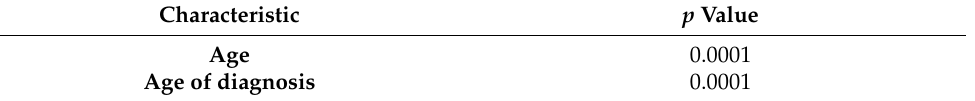
Figure 1. Correlation analysis between telomere length and clinical variables. Correlation between the telomere length using rt-PCR and clinical variables: ( a ) Telomere length and age ( p = 0.9004); ( b ) Telomere length and body mass index ( p = 0.1748); ( c ) Telomere length and HbA1c ( p = 0.3335). All three variables were found not to be statistically significant. Table 4. Correlation analysis between telomere length and clinical variables in the LADA group.